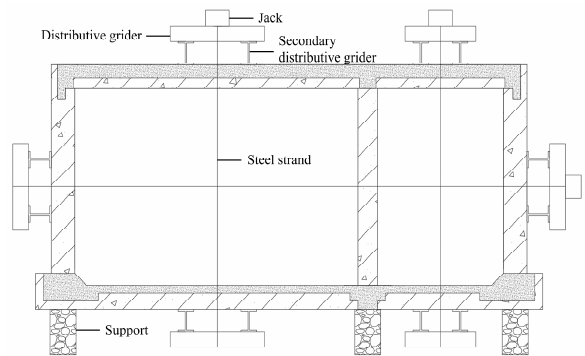
Figure 4. Test loading devices.